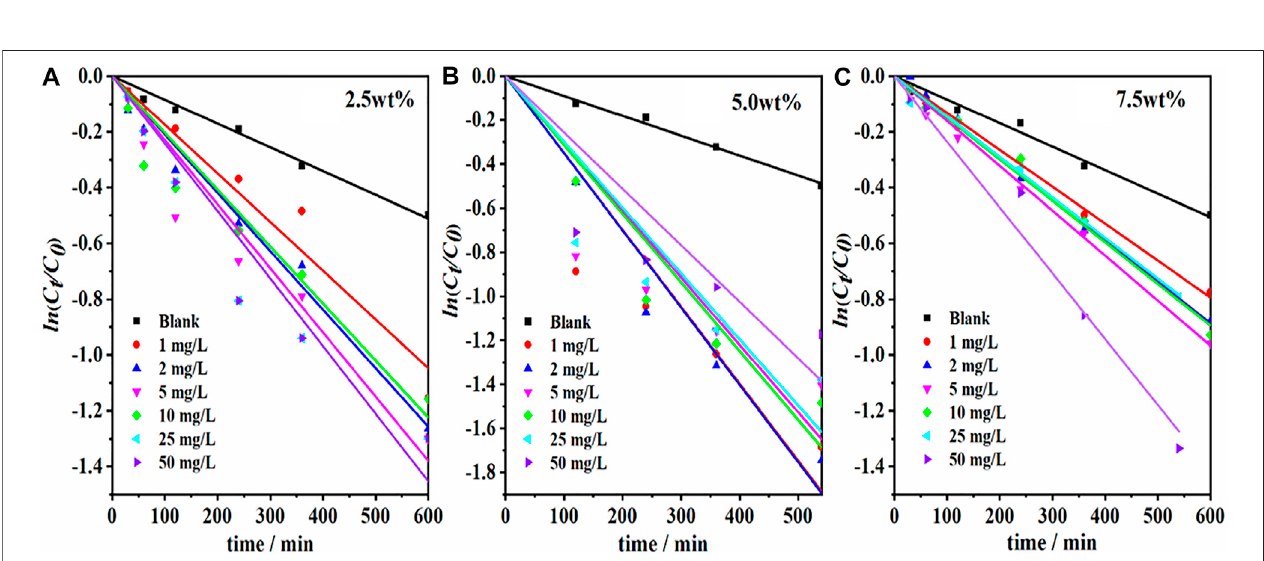
FIGURE 6 | Degradation of SDZ by different g-C 3 N 4 loading ( (A) 2.5% wt, (B) 5.0% wt, (C) 7.5% wt) and different concentration g-C 3 N 4 /Ag/ γ -FeOOH (0, 1, 2, 5, 10, 25, 50 mg/L).